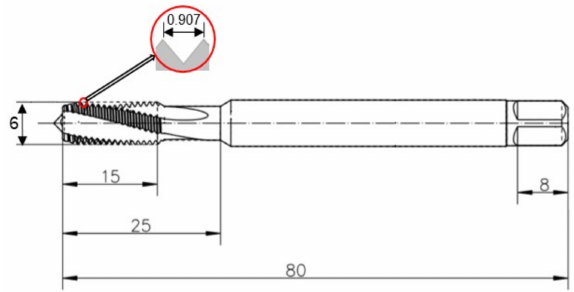
Figure 3. PARADUR TI-234164-UNF1/4” tap